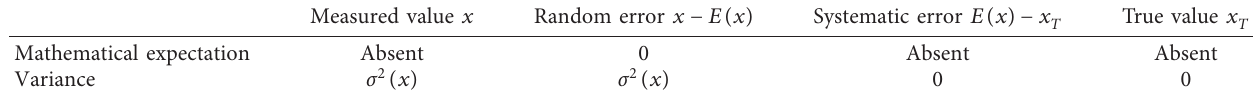
Table 2: The conceptual trouble of missing mathematical